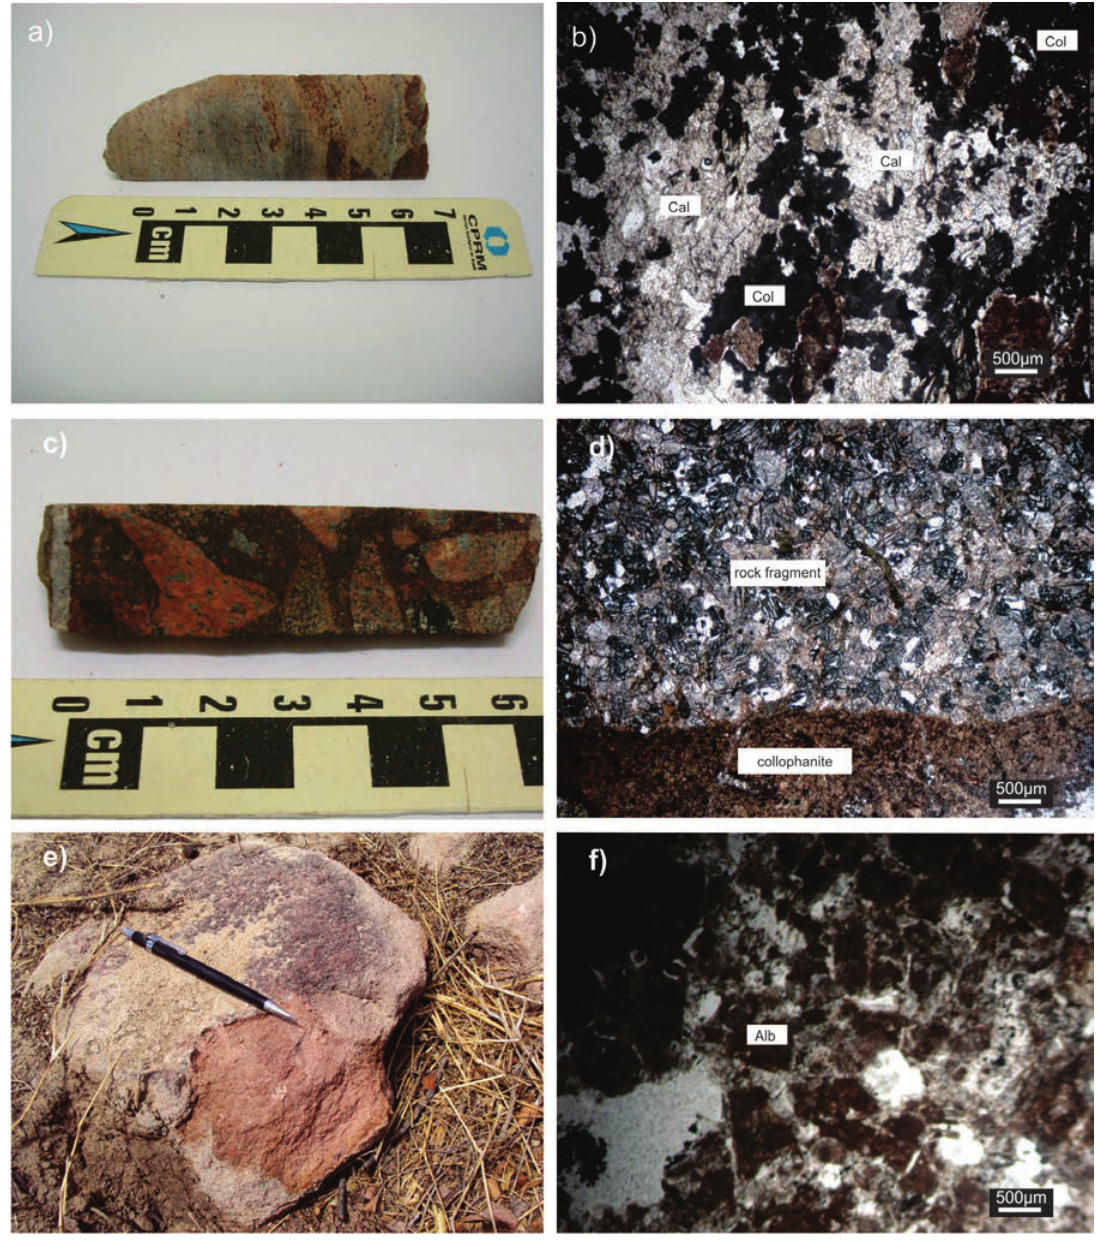
Figure 5 - Photos and photomicrographs showing outcrops and thin section images of the main prospects (see Figs. 3 and 4). i) Mandacarú – a) drill core of marble with collophanite impregnation; b) thin section, showing collophane (Col) impregnated in the interstices of calcite crystals (Cal). ii) Serrotes Baixos - c) drill core of breccia with matrix impregnated with collophane; d) thin section showing rock fragment and collophanite in breccia. iii) Taperuaba - e) outcrop of albitite; f) thin section showing albite crystals (Alb) with supergene